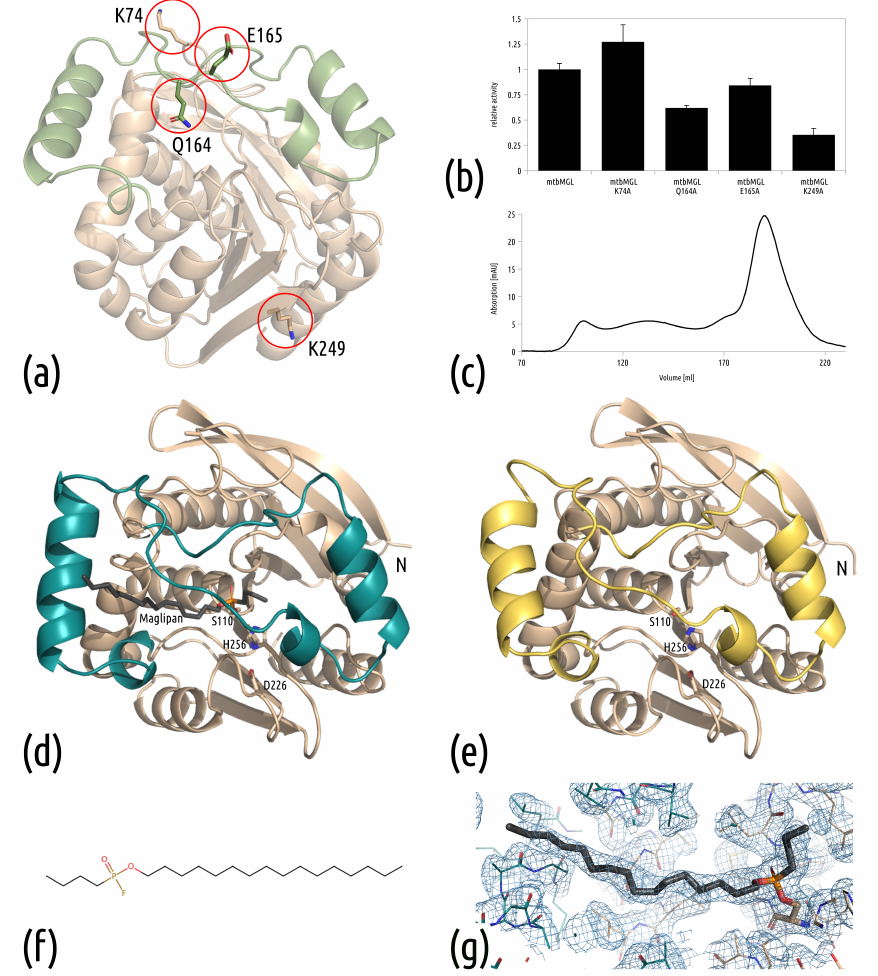
Figure 1. ( a ) Positions of the SER mutations displayed on the wt mtbMGL structure (PDB: 6EIC), cap domain in green, core fold in beige. ( b ) Monoacylglycerol hydrolase activity of mtbMGL K74A, mtbMGL Q164A, E164A and K249A, relative to wt mtbMGL. Here, 100% of wt mtbMGL activity corresponds to 276 ± 16 µ mol glycerol/(h*mg protein). ( c ) Size exclusion chromatogram of mtbMGL K74A after Ni-affinity purification. The monomeric fraction (eluting around 200 mL) was used for crystallization. ( d ) The complex structure of the SER variant mtbMGL K74A with the covalently bound substrate analog Maglipan. The catalytic triad is labeled and shown as a stick representation. ( e ) The overall structure of the surface entropy variant mtbMGL K74A with a closed cap conformation. The catalytic triad is labeled and shown in sticks representation. ( f ) The unbound structure of the substrate analog Maglipan ( g ) Maglipan from chain A of the complex structure 7P0Y, bound to S110 with electron density (2F o –F c at a 1.0 sigma contour level). The surrounding protein residues are shown as line